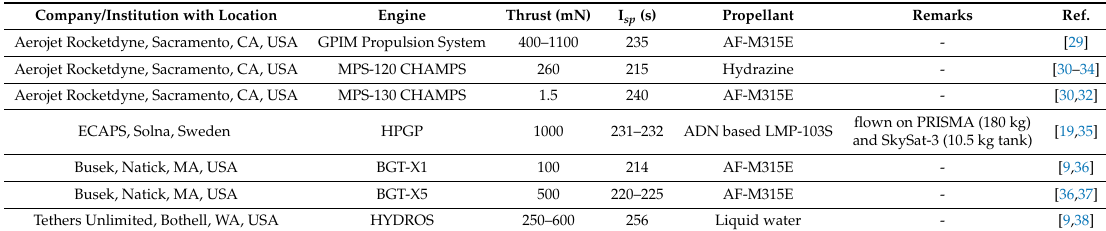
Table 2. Summary of Liquid Propulsion